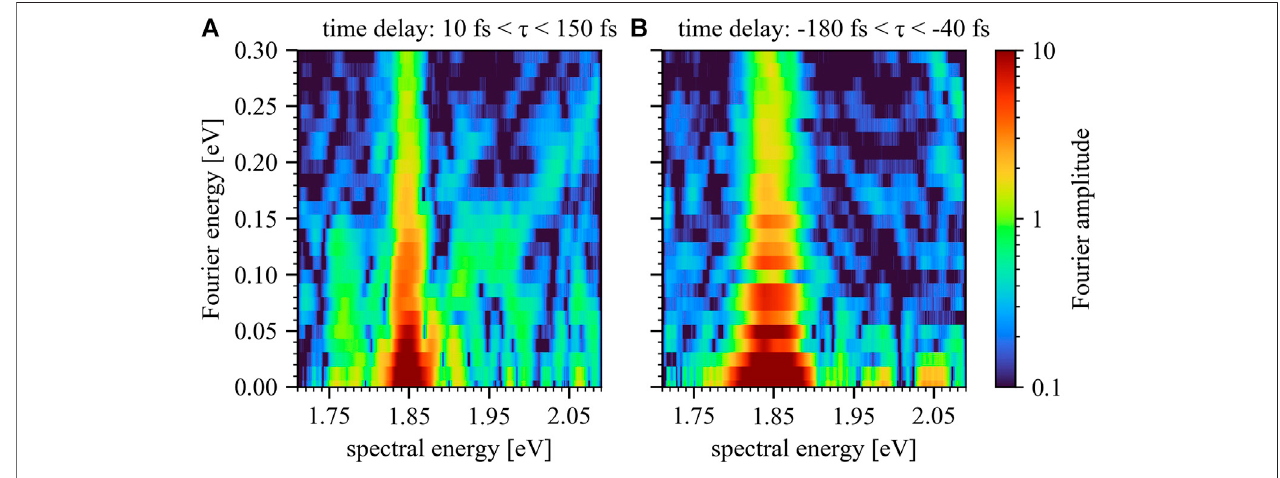
FIGURE6 | Fourier plot for positive (A) and negative (B) time delays ofthe Δ OD ( ω , τ ) depicted in Figure 5B .Diagonalsofslope ± 1pointingat a spectral energy of approximately 1.84 eV can be observed in the Fourier plot only for positive time